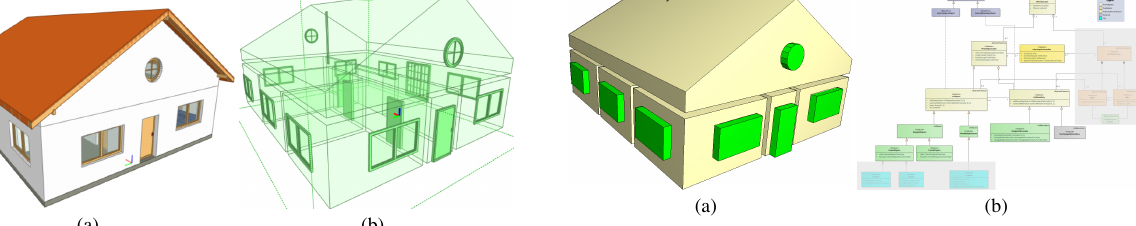
Figure 6. Input IFC model. (a) The full BIM model. (b) The spaces and opening of the model.